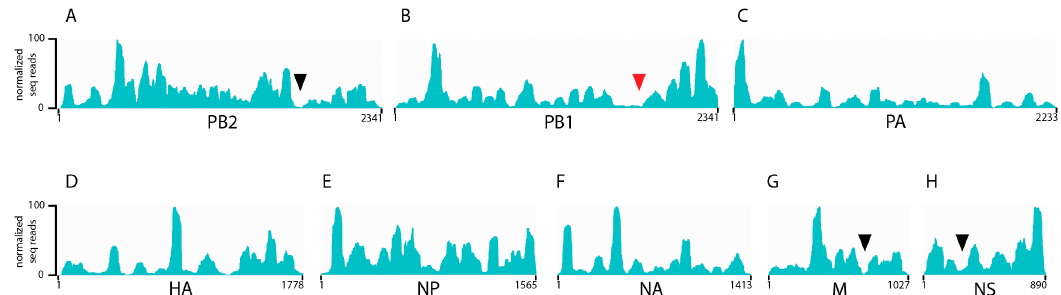
Figure 1. NP binding profile for seasonal H3N2 A/Panama/07/1999 strain ( A – H ). The abundance of NP on each vRNA segment was examined using HITS-CLIP on purified virions. Cell-grown virions were concentrated on a sucrose cushion, UV-crosslinked, treated with a partial RNase digestion, and was followed by immunoprecipitation with an anti-NP monoclonal antibody. A representative profile for each segment is presented as an IGV track. The nucleotide lengths and segment names are shown on the x-axis. Normalized reads, based on the highest peak, are displayed on the y-axis. Low NP-binding areas are indicated by black and red arrowheads.